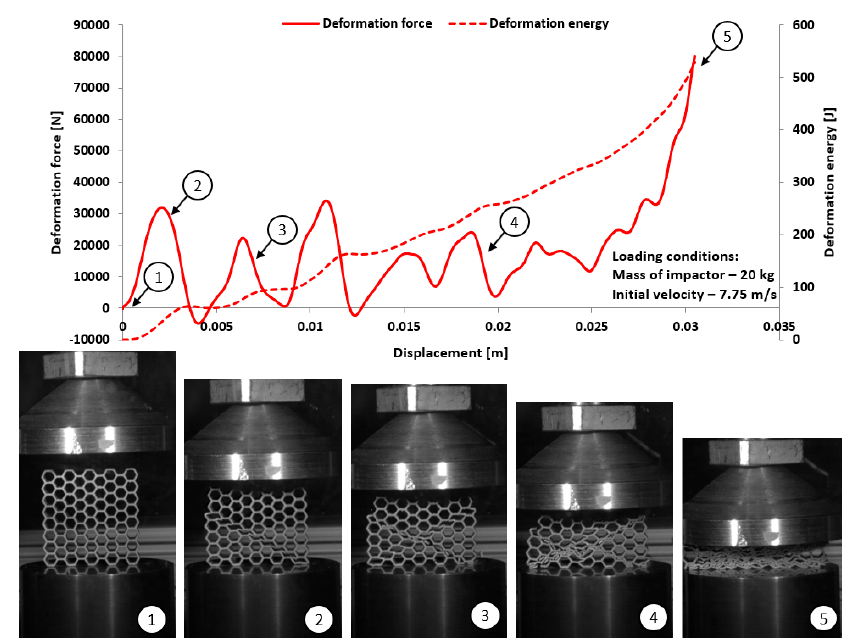
Figure 18. The results of dynamic tests obtained for honeycomb specimen No. 2 (1–5 stages of deformation during dynamic compression test).